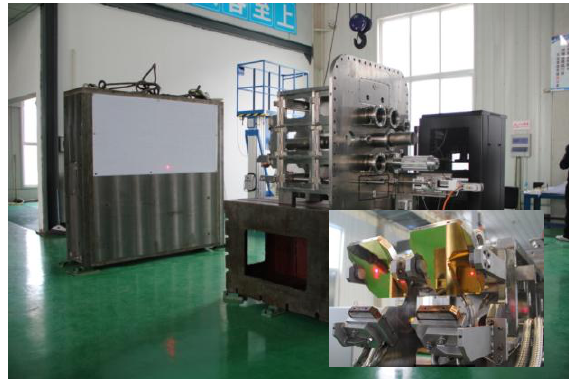
Fig. 8. Optical calibration of the